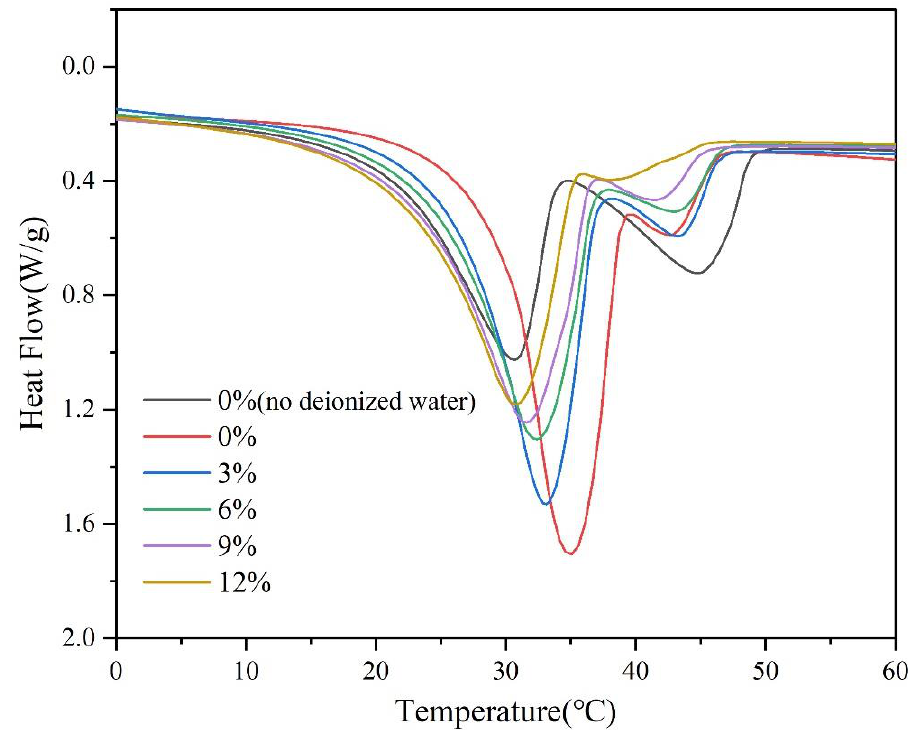
Table 2. Thermal characteristics of composite PCMs with different DHPT content. Figure 4. DSC curves of composite PCMs containing different contents of Figure 4. DSC curves of composite PCMs containing different contents of DHPT.